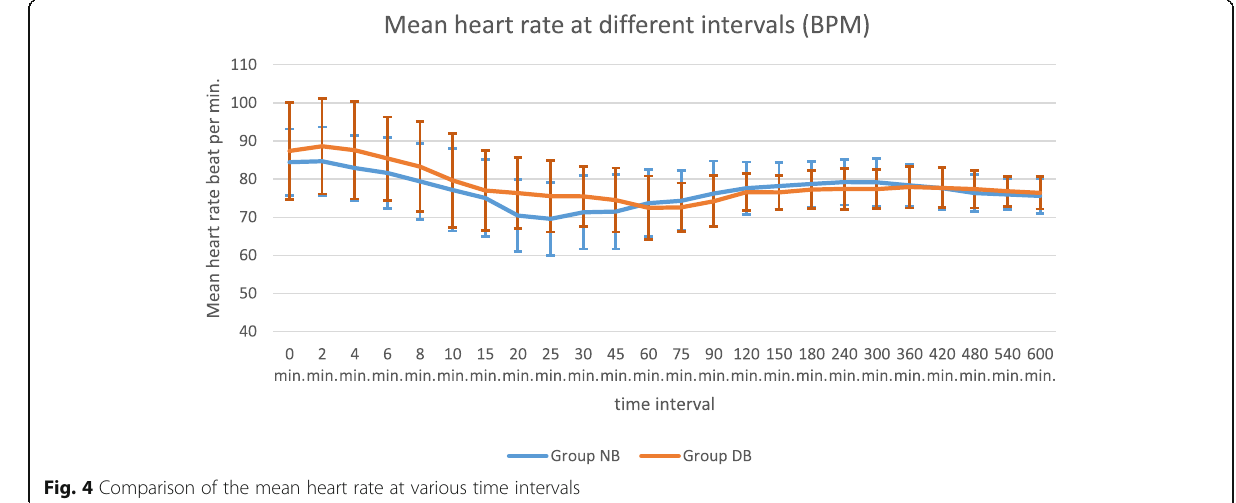
Fig. 4 Comparison of the mean heart rate at various time intervals